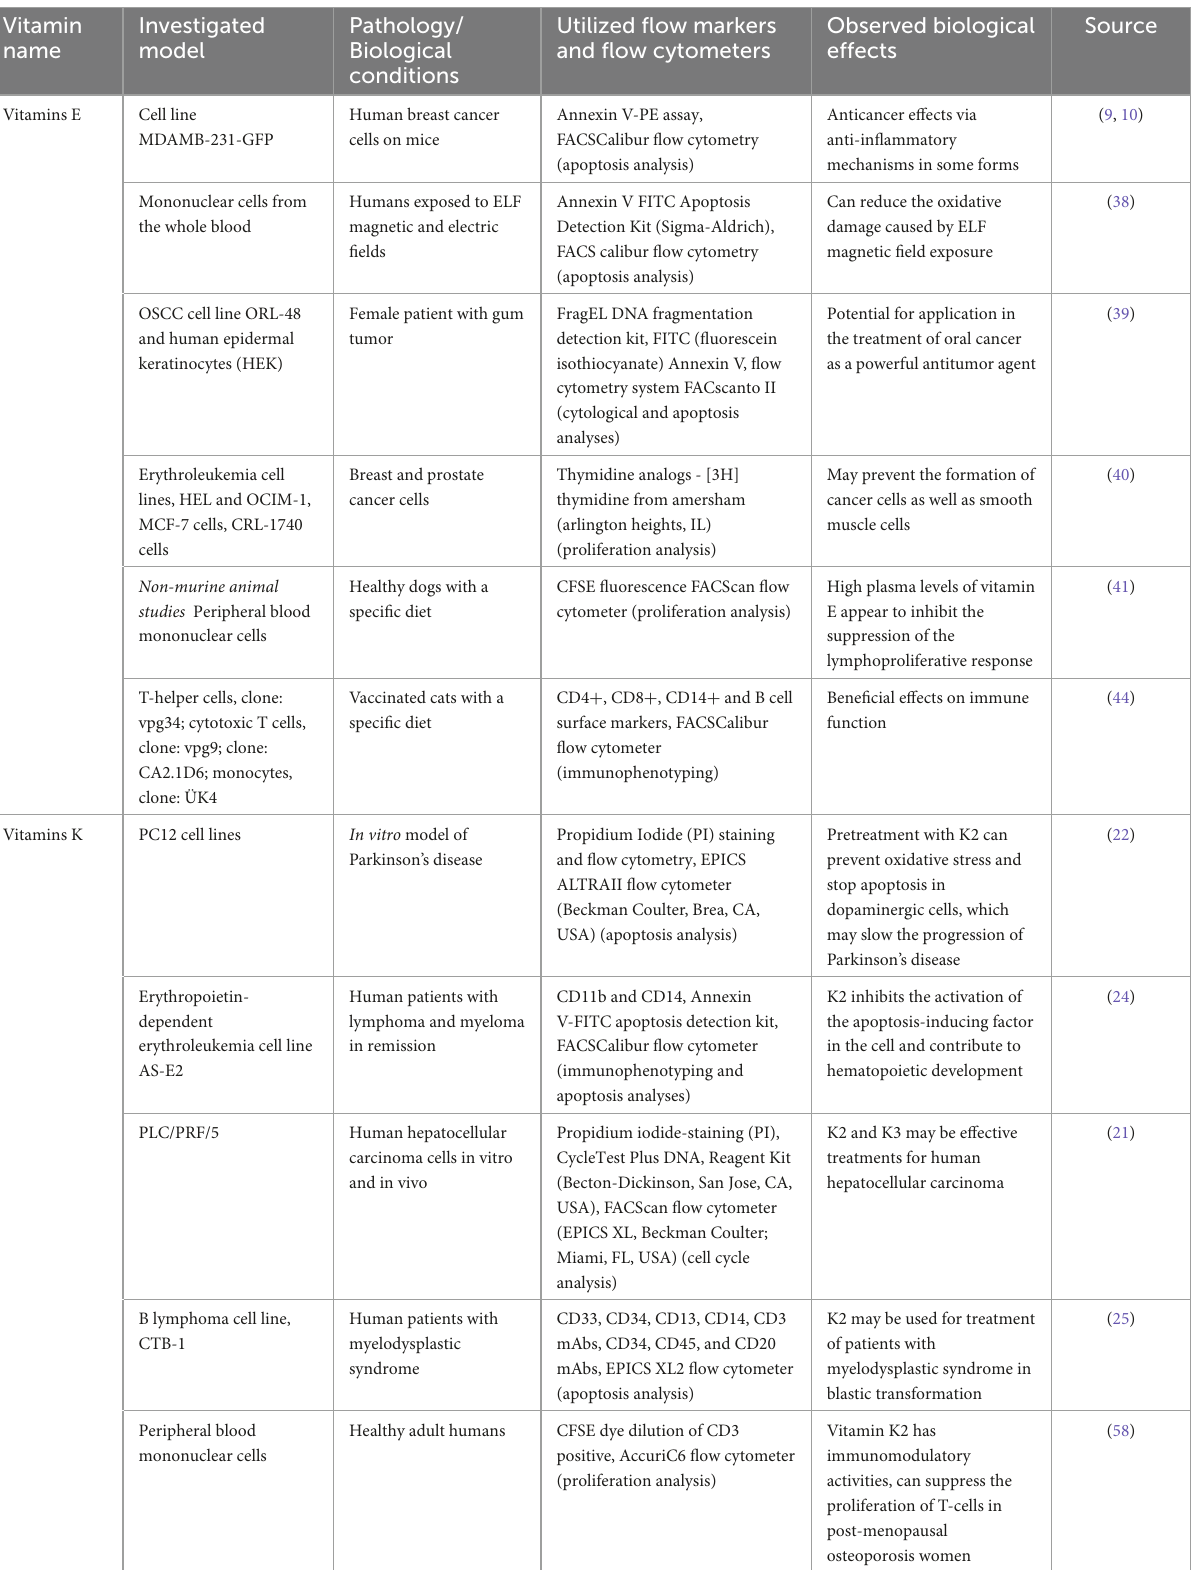
TABLE 1 Vitamins effects evaluated by flow